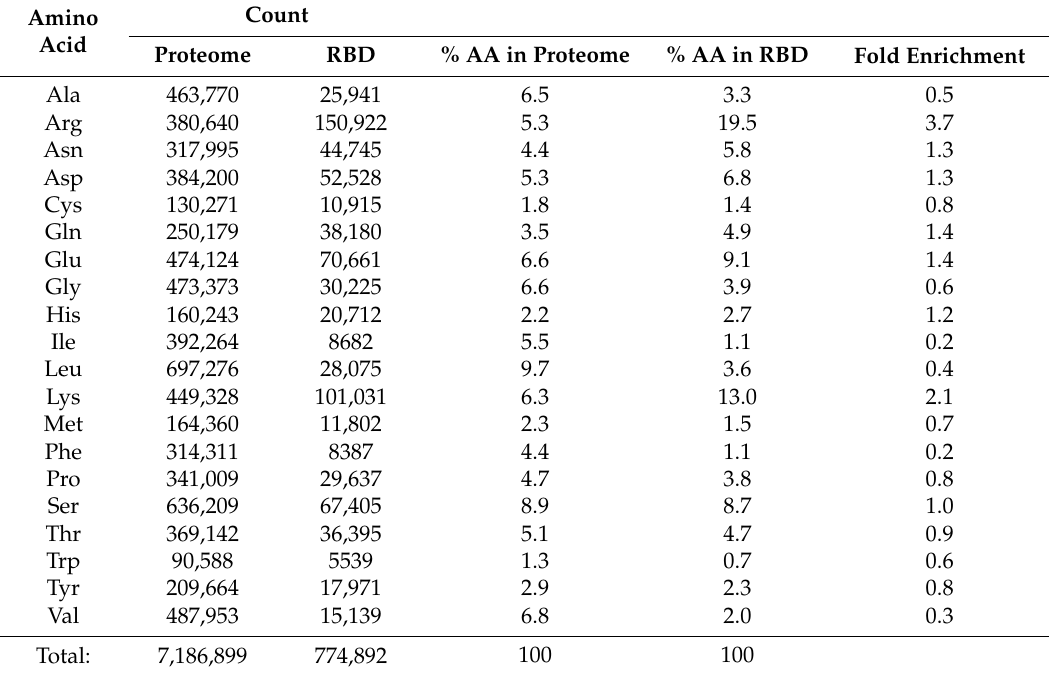
Table 4. Receptor binding domain (RBD) analysis of the proteome of Arabidopsis